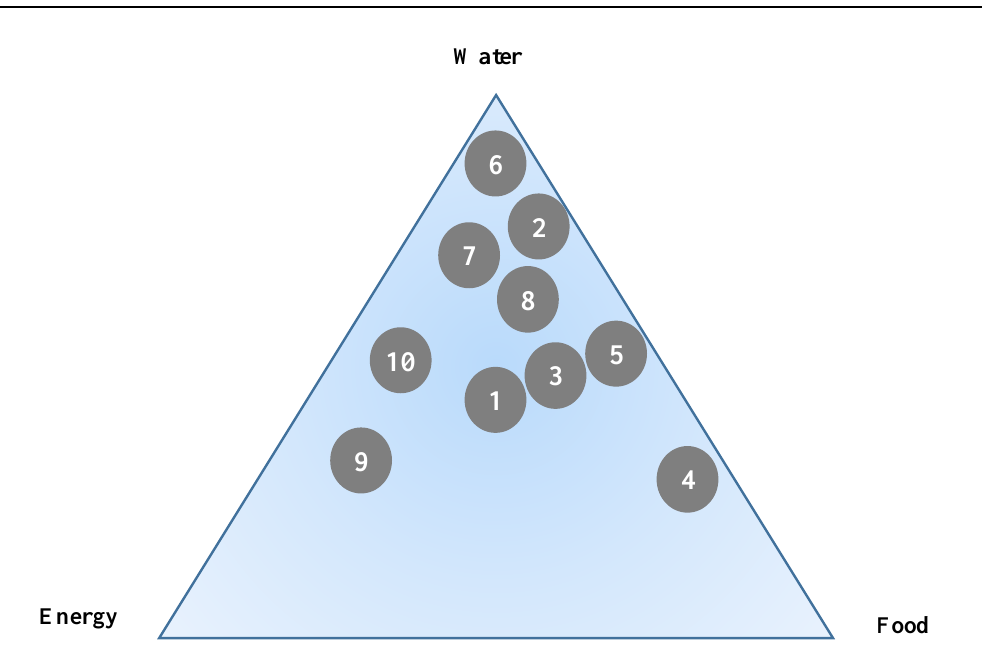
Figure 8. The conceptual location of references related to SDGs and water-energy-food nexus (please see Table 5 for the meaning of the number).